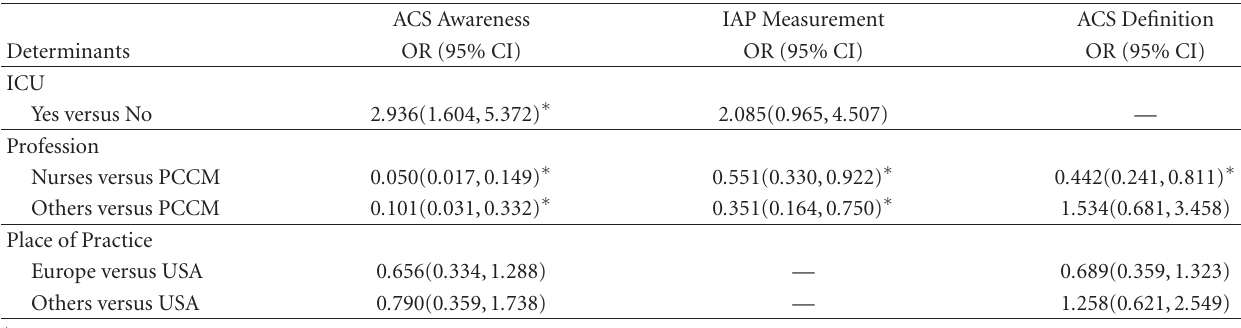
Table 3: Multivariable analysis of factors a ff ecting ACS awareness, IAP measurement, and knowledge of ACS